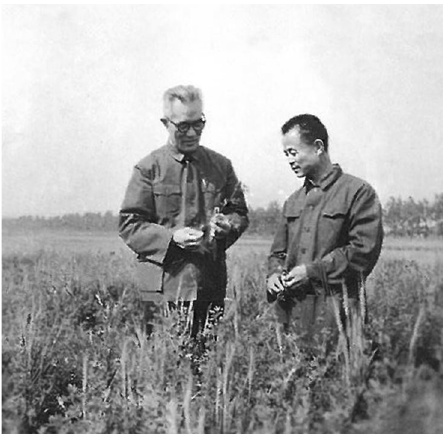
Figure 6. Dr. Fan in a fi eld of Astragalus sinicus .